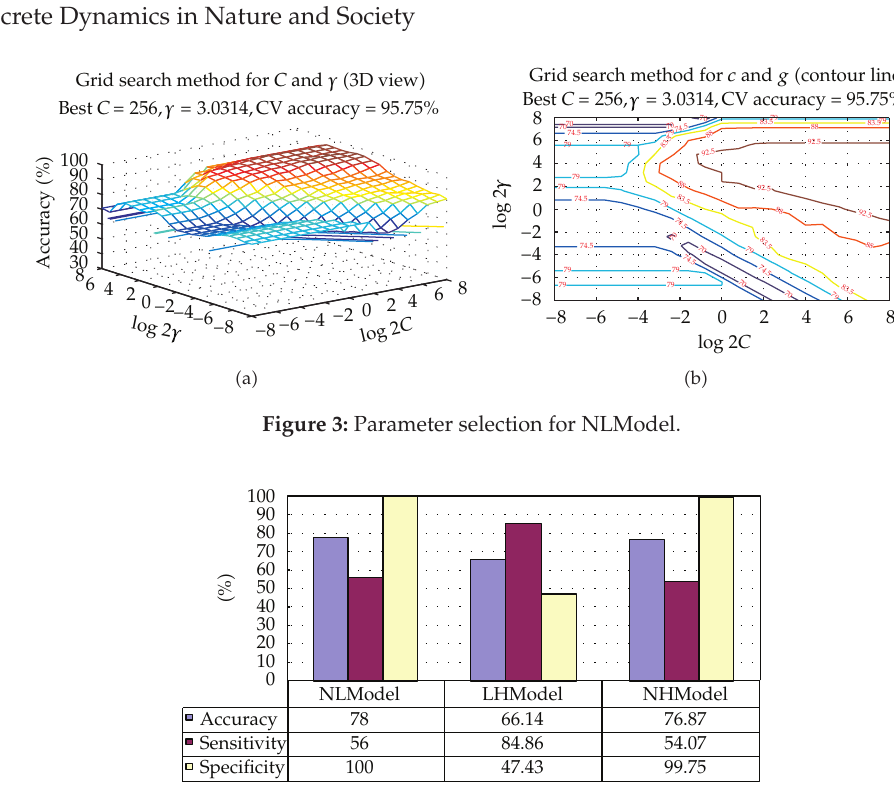
Figure 4: The detecting performance for NLModel, LHModel, and